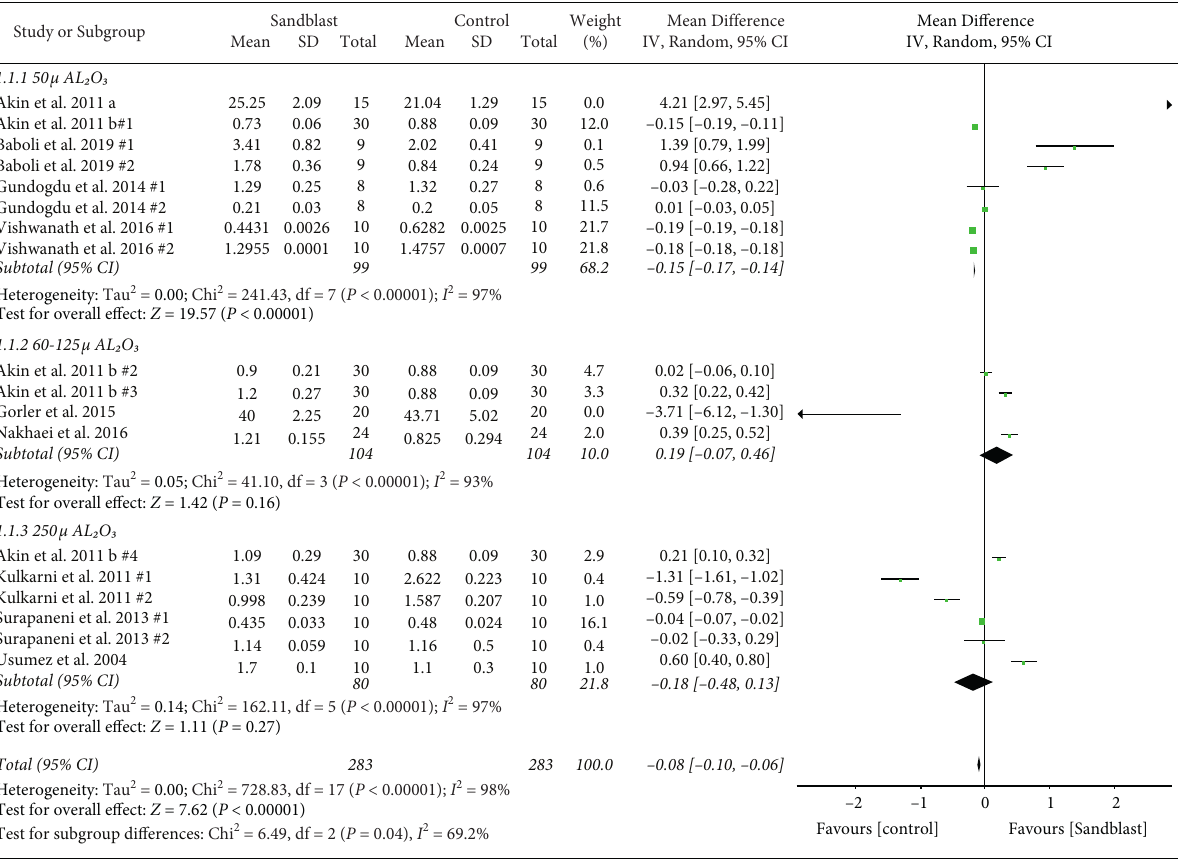
Figure 5: Forest plot for subgroup analysis of particle size for tensile bond strength.